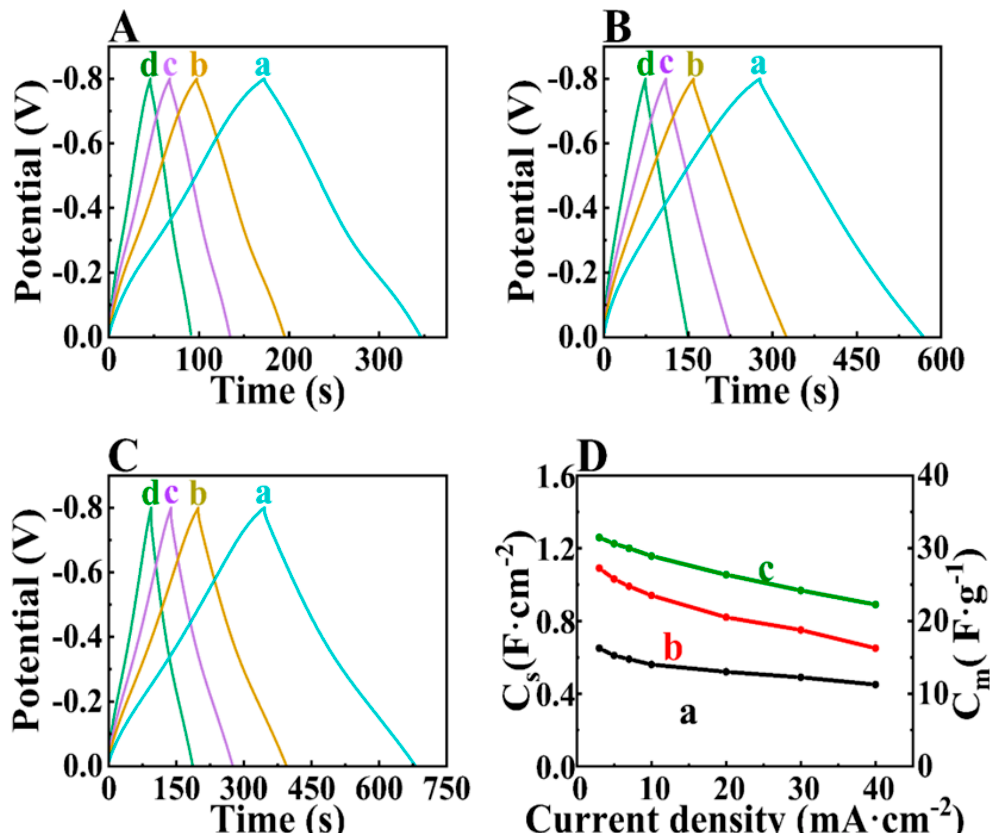
Figure 9. ( A – C ) GCD data for ( A ) composite 1, ( B ) composite 2 and ( C ) composite 3 at current densities of (a) 3, (b) 5, (c) 7 and (d) 10 mA.cm − 2 and ( D ) capacitance versus current density for (a) composite 1, (b) composite 2 and (c) composite 3.